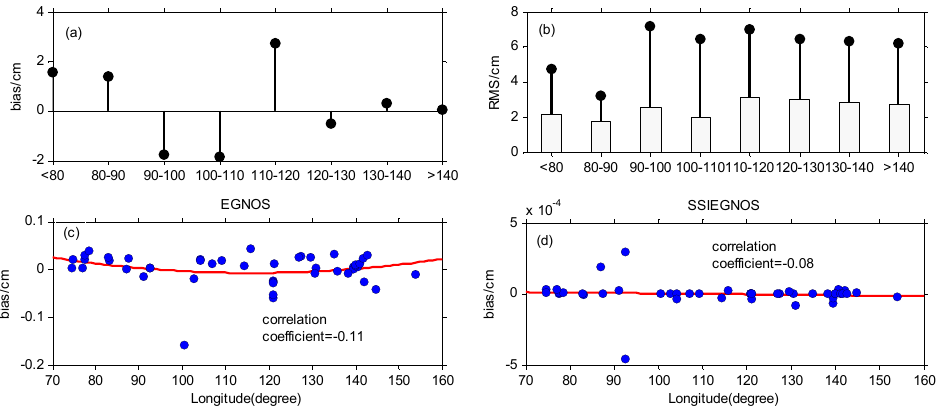
Figure 8. ( a , b ) show the annual bias and RMS error in each longitude range; whereas ( c , d ) show the mean correlations between bias and longitude. Black stems and white bars represent the mean bias and RMS error of the EGNOS and SSIEGNOS models, respectively.